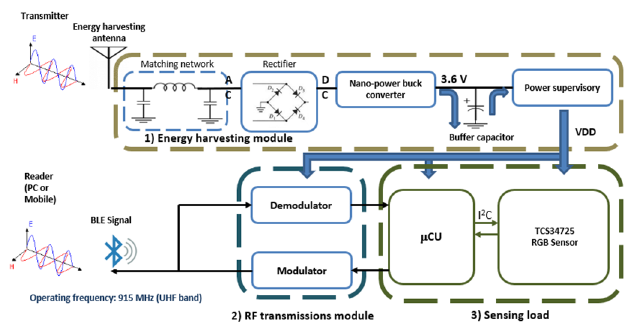
Figure 1. The proposed RF scavenging module.